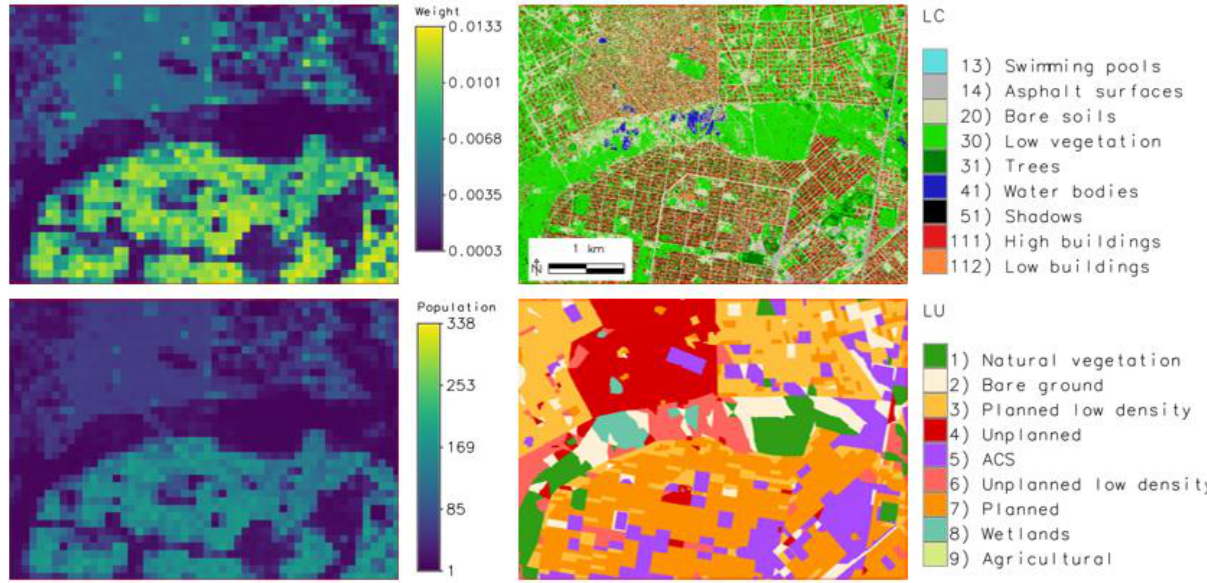
Figure 7 . Comparing the LC, LU, weighted layer and final predicted population counts.